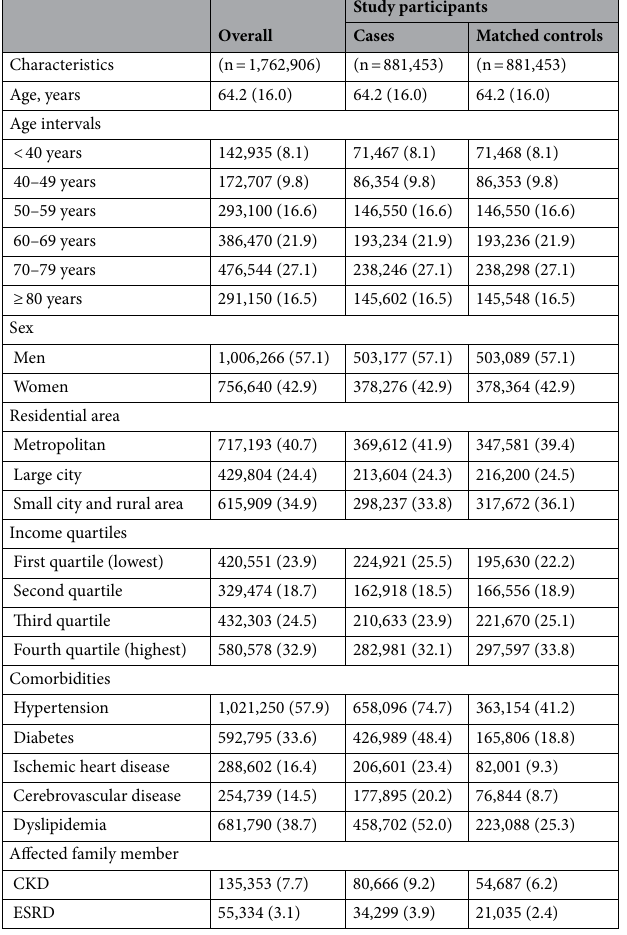
Table 1. Baseline characteristics of the study participants. Data are presented as means (standard deviation) or numbers (percentages). CKD chronic kidney disease, ESRD end-stage renal disease.